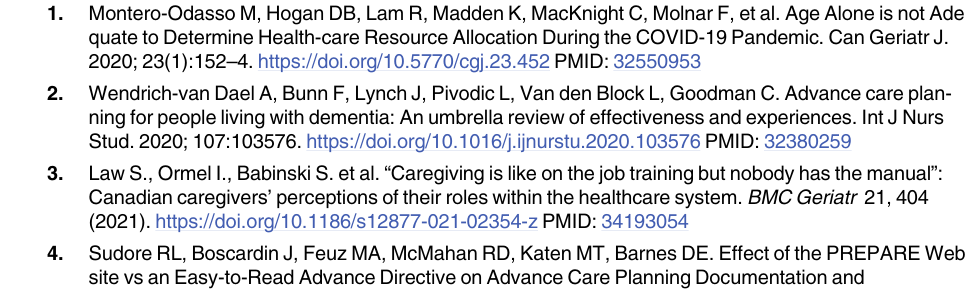
S1 Table. Categories and subcategories related to the acceptability of VYV with additional